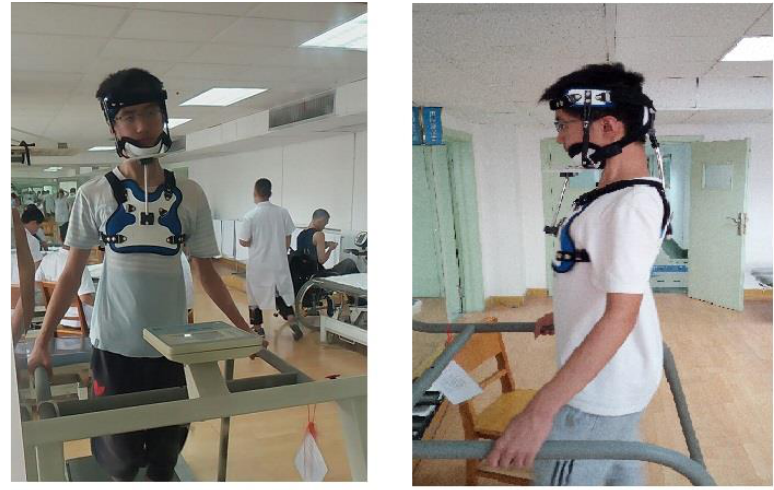
Figure 5. Three-dimensional PCO to perform the mirror image therapy (reverse posture training) while the patient was walking on motorized treadmill.